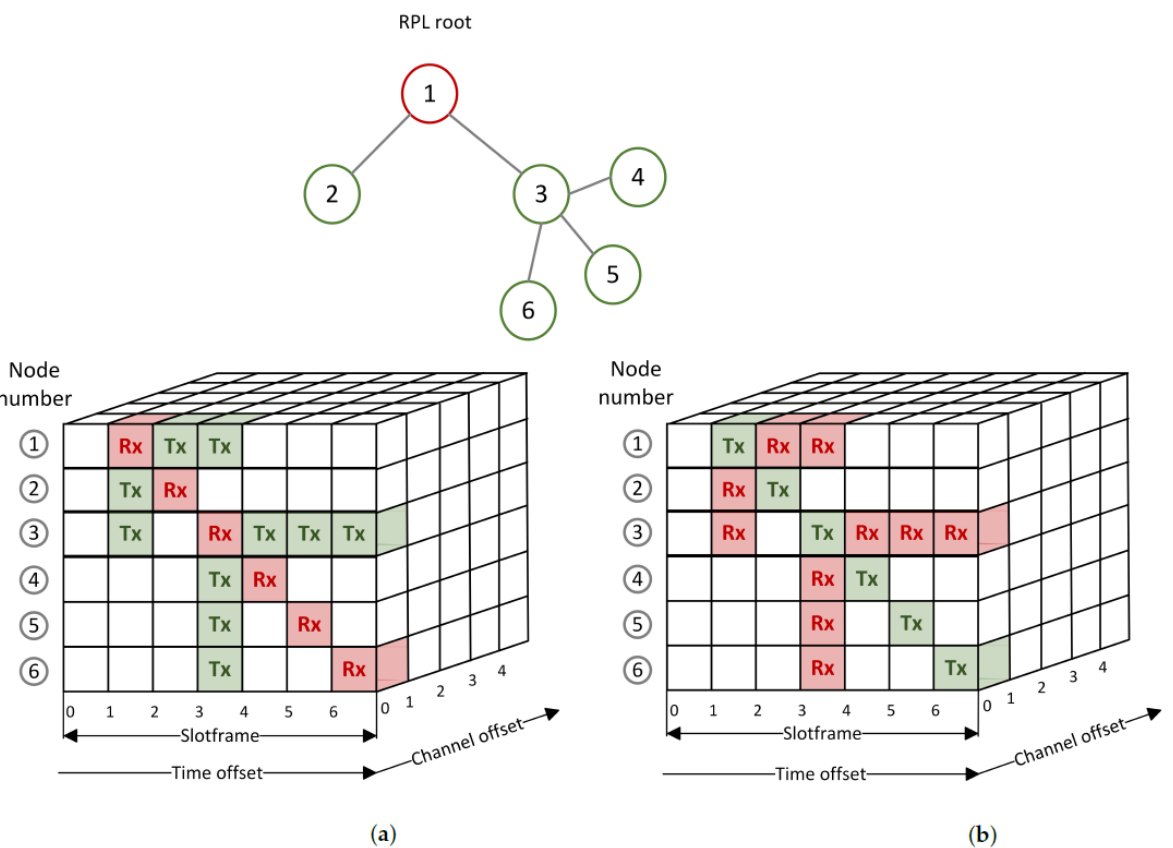
Figure 2. Example of scheduled Rx and Tx cells for nodes 1 to 6 in the time/channel offset space. The Rx cells are highlighted with red and the Tx cells with green. ( a ) Receiver-based shared (RBS) cell allocation. ( b ) Sender-based shared (SBS) cell